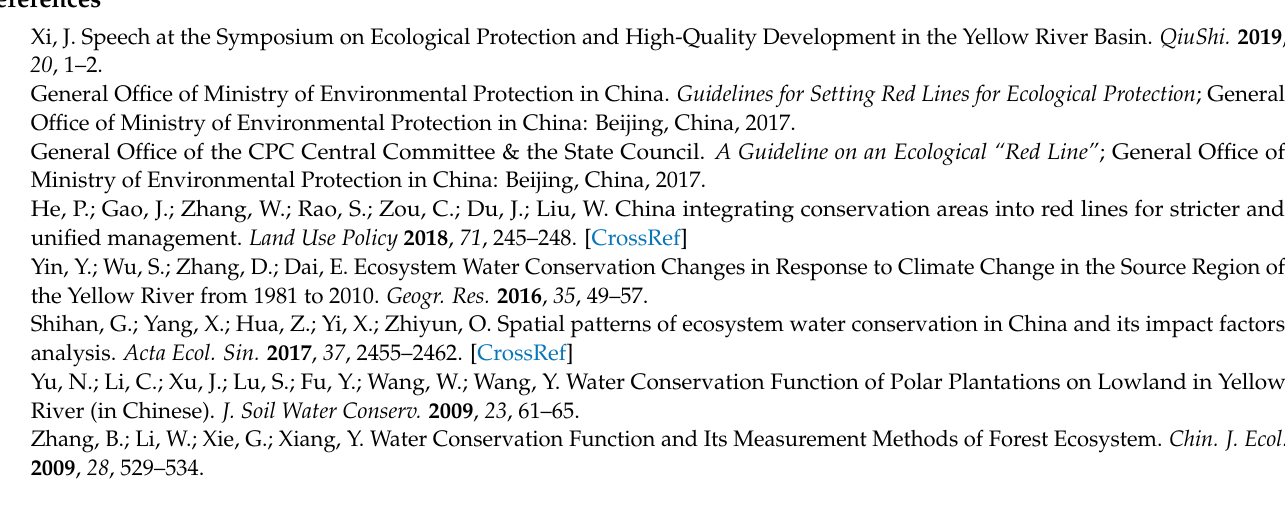
Sample Number for